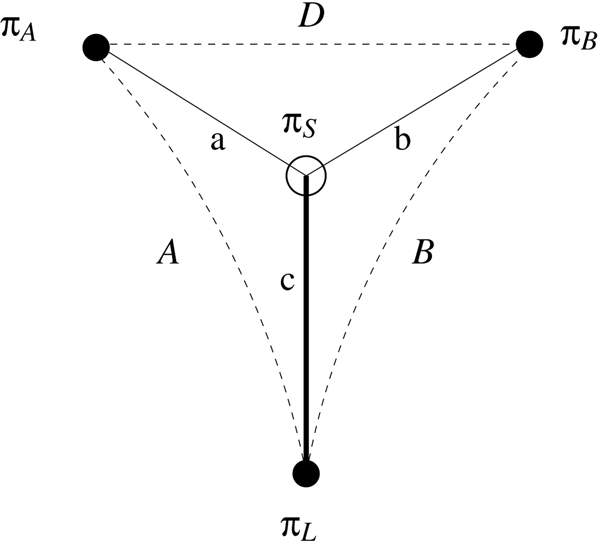
The distances around a signature πS.